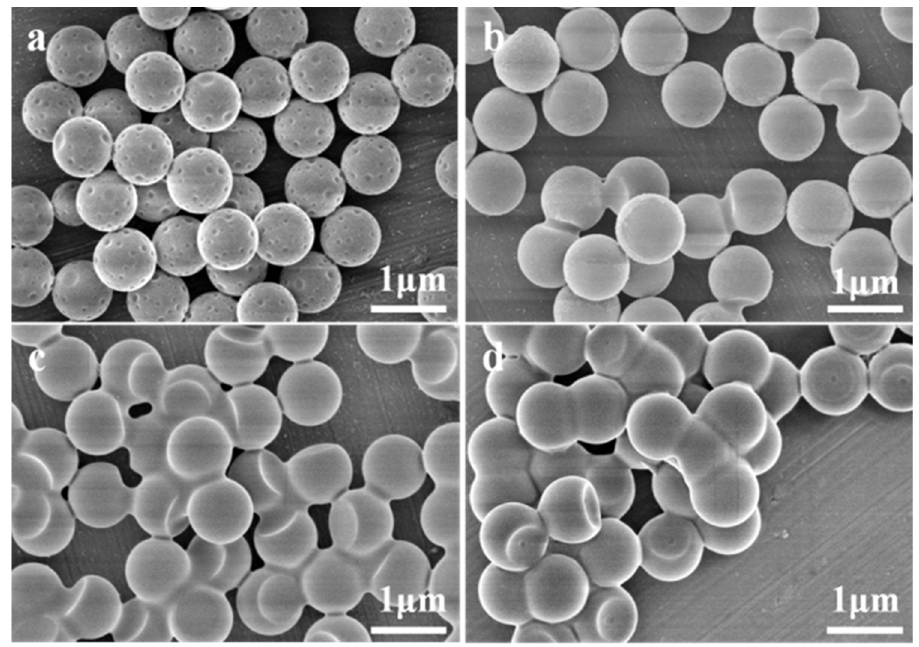
Figure 2. SEM images of PS/P(OFMA-S) composite particles synthesized with w OFMA / w St of 1 and w PX / w PS of 2 at different polymerization temperatures: ( a ) 60 °C, ( b ) 70 °C, ( c ) 80 °C, ( d ) 90 °C.